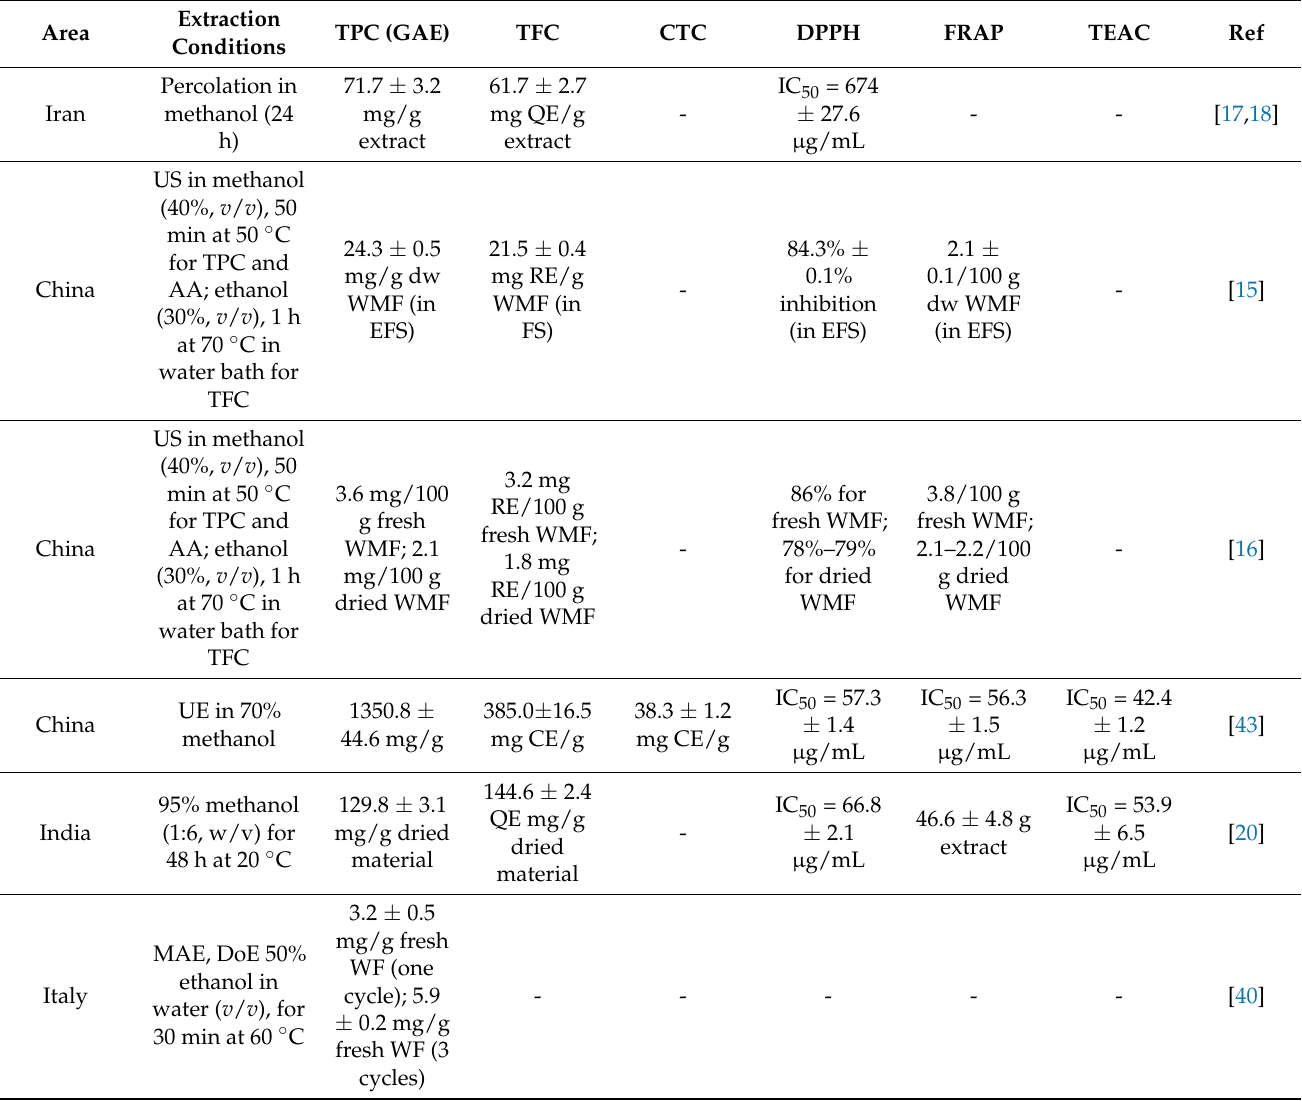
Table 6. Phenolic content and antioxidant activity for walnut flower extracts (WMFs) and type of extraction method.